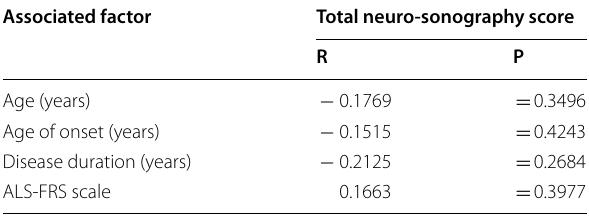
r: Pearson’s rho (correlation coefficient)